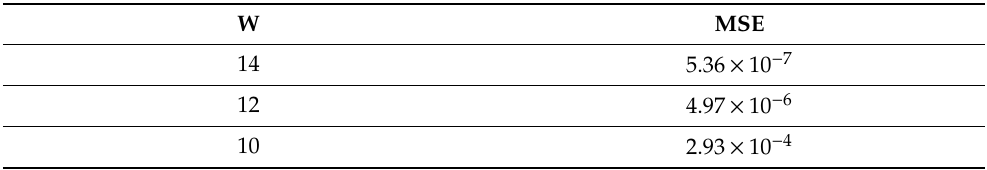
Table 10. Mean square error (MSE) between the software and the proposed hardware implementations for nonlinear